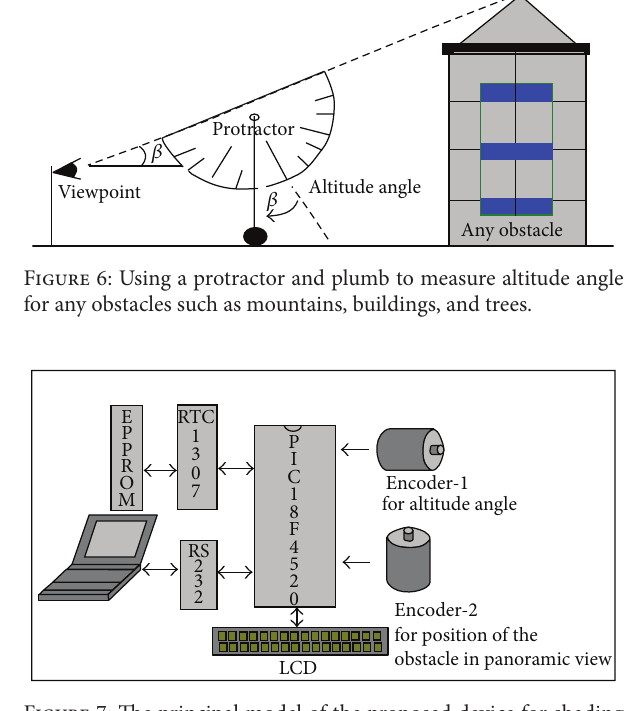
Figure 7: The principal model of the proposed device for shading